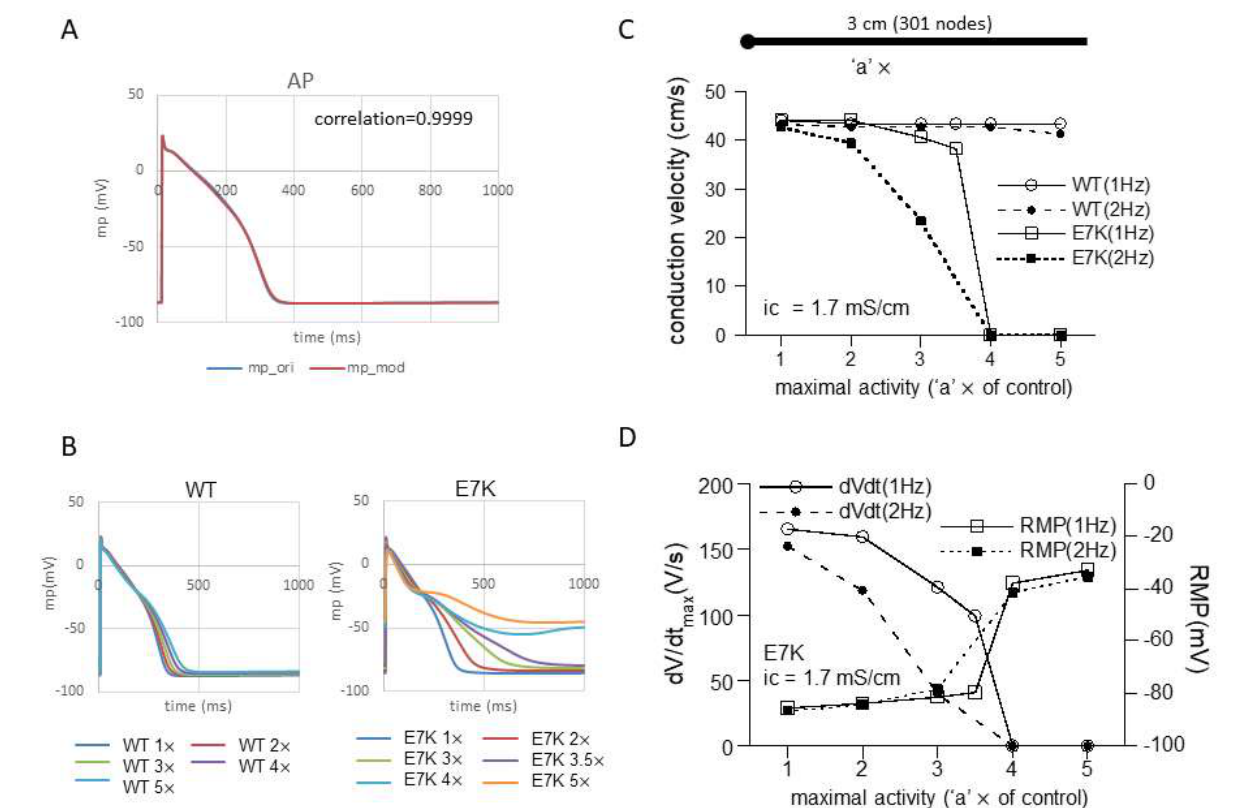
Figure 6. E7K mutation causes conduction block. ( A ) modified human Purkinje fiber Trovato2020 model (for details, see the Methods) was employed to simulate action potential (AP) and conduction velocity (CV). A; adaption of TRPM4 gating kinetics to the original Trovato model. ( B ) single-cell AP simulations by modified Trovato model incorporated with the gating kinetics of either wild-type (left) or E7K-mutant (right). The results are overlaid for each. ( C ) relationships between conduction velocity (CV) and channel density (or maximal activity) with intracellular conductivity of 1.7 mS/cm at 1 or 2 Hz pacing. The channel density is presented as a multiple (‘a’ × ) of control (i.e., 7.02 × 10 − 8 Litre/farad/ms) for wild-type and E7K-TRPM4 channels. The horizontal bar on the top panel in C denotes a 3 cm-long cable (stimulating point of 0–0.05 cm is shown as a large filled circle on the left). To avoid boundary effects, CV was calculated between 0.2 and 2.8 cm. ( D ) relationships of maximal upstroke slope of propagated AP (dV/dt max ; measured at 2.8 cm) or resting membrane potential (RMP) against TRPM4 channel density which is shown as the fold increase (‘a’ × ) as in ( C ) .